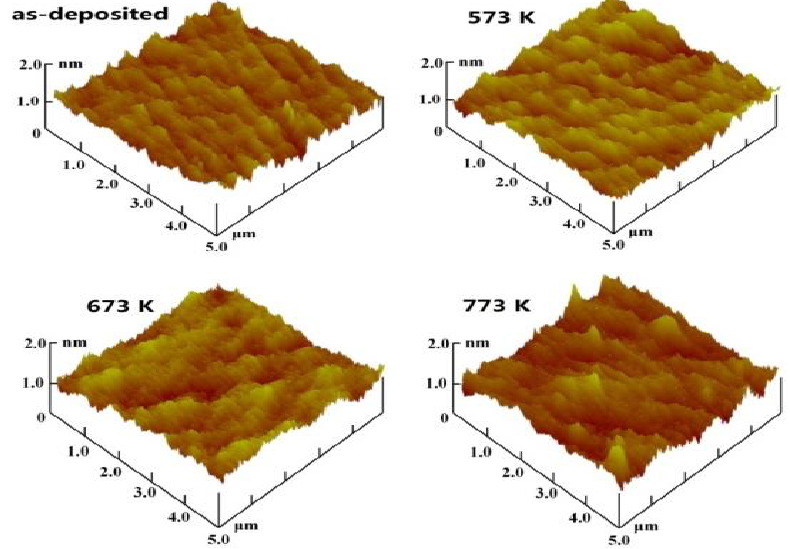
Figure 6. AFM image of the as-deposited Ta 2 O 5 films with thickness of 500 nm annealed at different temperatures; the scanning range is 2.5 μm × 2.5 μm. Scale bar of the Z range is 2 nm.